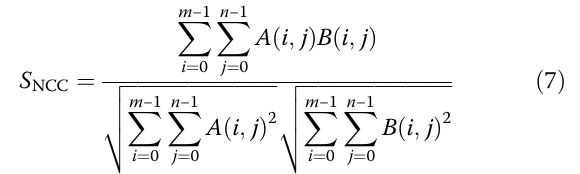
Algorithm 1 Pseudo-code implementation of